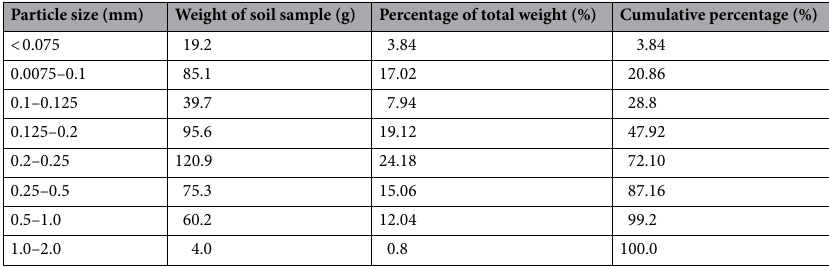
Table 1. Particle analysis statistics for